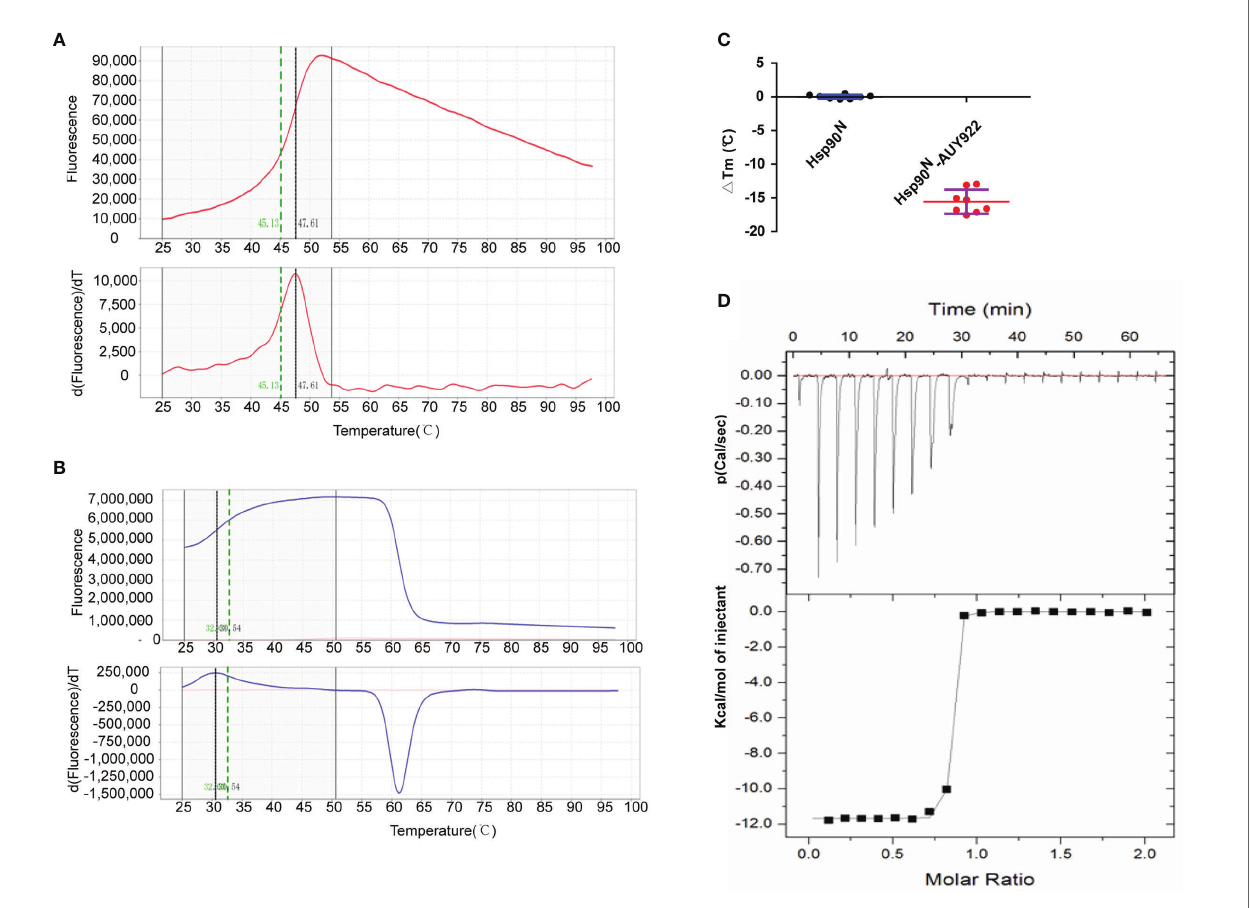
FIGURE 2 | New NVP-AUY922 derivatives design according to complex crystal structure and molecular docking evaluation. (A) Design scheme for new NVP- AUY922 derivatives. (B) Top ten new derivatives with the highest Total scores evaluated by molecular docking using SYBYL-X 2.0 software. (C) Simulated overall 3D structure of Hsp90 N -A15. Cartoon for Hsp90 N and stick for A15. (D) Simulated intermolecular force between Hsp90 N and A15. For A15, the carbon, nitrogen, oxygen and sulfur atoms of were marked in green, blue, red and yellow, respectively. For Hsp90 N , the carbon, nitrogen, oxygen and sulfur atoms were marked in cyan, blue, red and yellow, respectively. The red dashed line represents the hydrogen bond. (E) Connolly surface of simulated complex 3D structure of Hsp90 N -A15. (F) Molecular structure of A15.